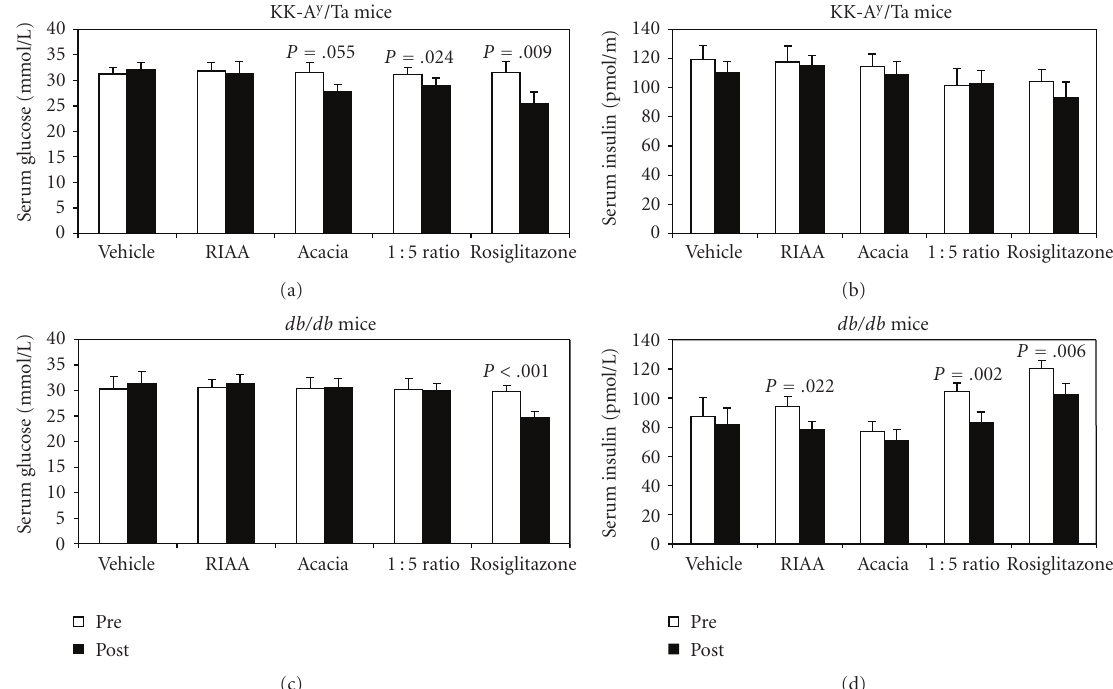
Figure 1: Nonfasting serum glucose and insulin concentration in KK-A y /Ta mice (a,b) and db/db mice